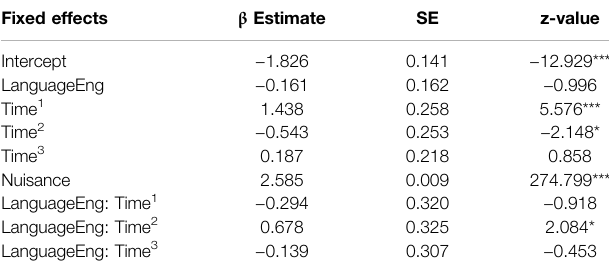
TABLE 2| Output ofthe modelonEP fi xations inPhase3(glmer (Hits~Language * (Time 1 + Time 2 + Time 3 ) + Nuisance + (1 + Time 1 + Time 2 | Item-pair) + (1 + Time 1 + Time 2 + Time 3 |